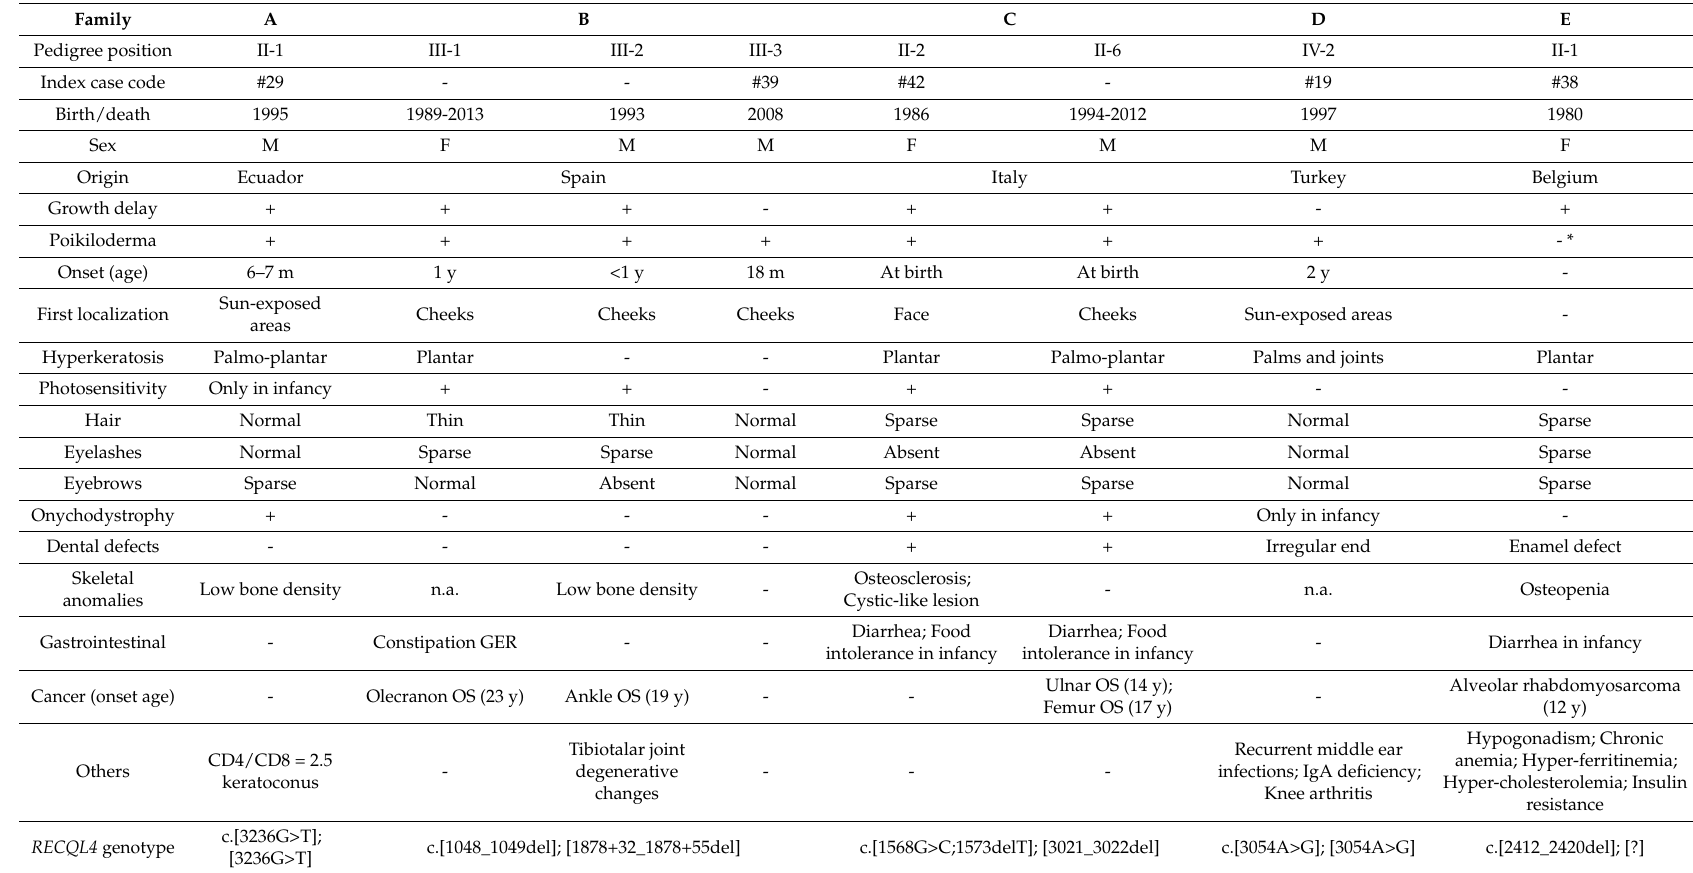
Table 1. Clinical characteristics of affected individuals from RTS